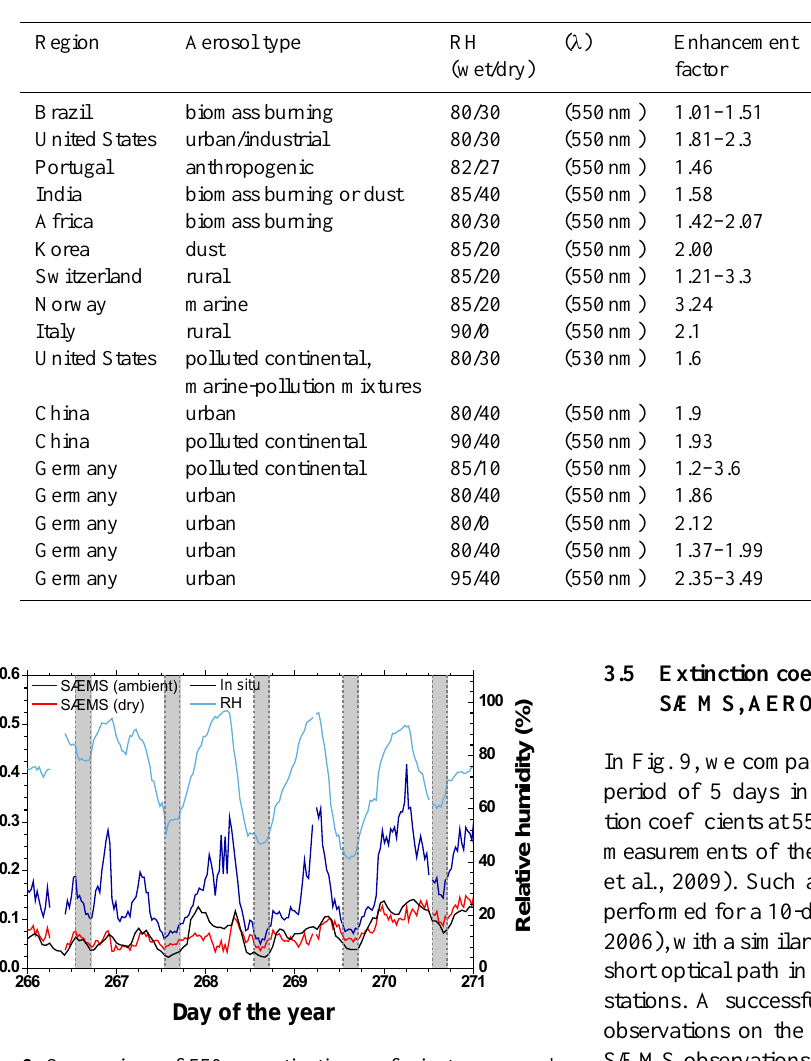
Figure 9. Comparison of 550nm extinction coefficients measured with SÆMS (ambient, dark blue) and computed from dry parti- cle size distributions (black) measured in situ at the roof of the TROPOS building from 24 to 29 September 2009. The humidity- corrected SÆMS (dry, 0% relative humidity) extinction time series is shown as a red curve. Relative humidity is given in addition as a light blue line. Gray shaded areas indicate the 13:00–17:00UTC periods during which the PBL is assumed to be well mixed; PBL depth takes its maximum, and relative humidity and particle extinc- tion take their minimum during sunny days (days 267, 268,